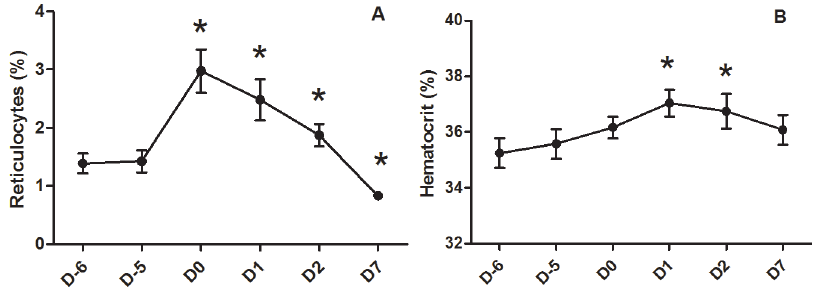
Figure 4. Effect of exposure to 32 6 C on percentage of reticulocytes and hematocrit in growing pigs. Mean 6 standard error. * means that daily value is significantly different (P , 0.05) from values at 24 u C (i.e., mean of D-6 and D-5).